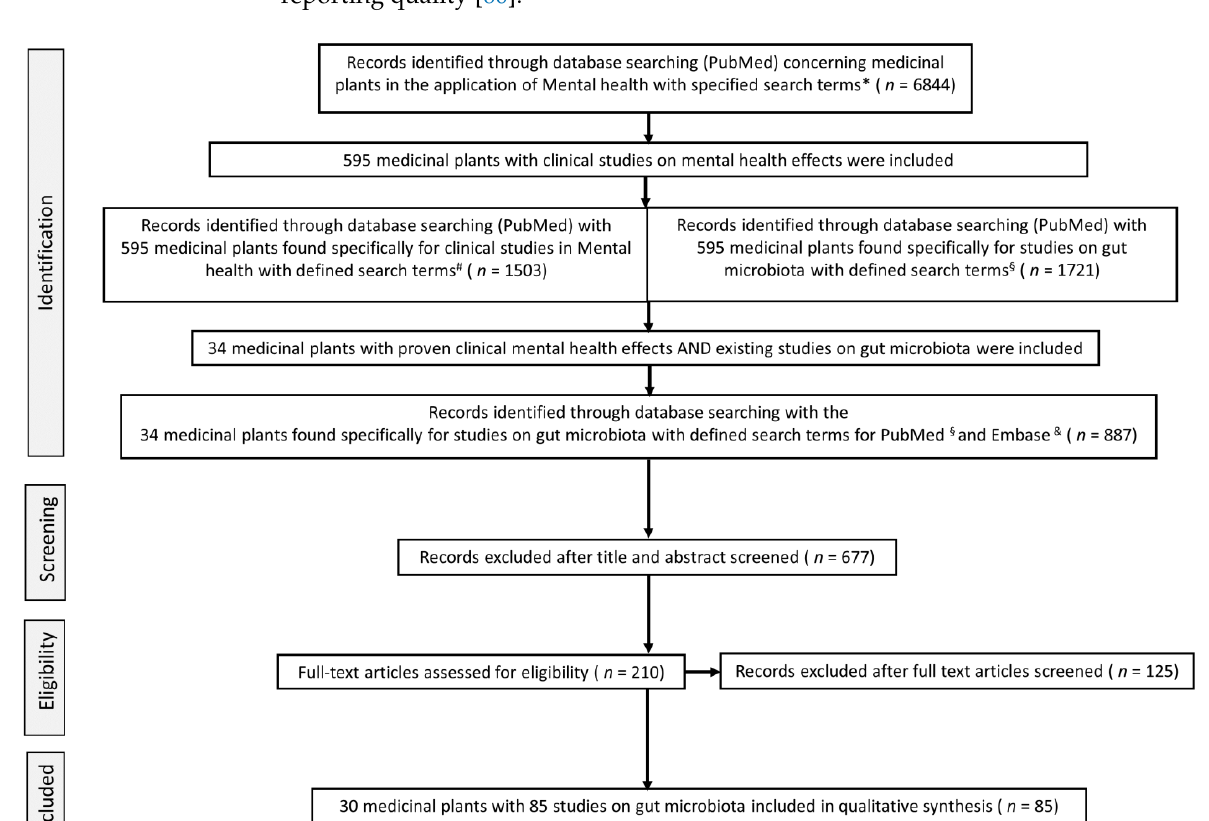
Figure 2. Flowchart of the selection strategy and method (PRISMA statement). * Search terms were as follows: ((medicinal plant *) AND ((antidepressant) OR (mental stress) OR (mood disorder*) OR (insomnia) OR (sleep) OR (anxiety) OR (cognitive impairment *) OR (circadian clock) OR (circadian rhythm) OR (dementia) OR (memory) OR (adaptogen*) OR (focus and attention) OR (fatigue)) NOT ((Alzheimer’s disease *) NOT (Parkinson’s disease *)). # Search terms were as follows: (plant name OR plant name OR ……) AND (clinical study) AND ((anxiety) OR (insomnia) OR (antidepressant) OR (cognitive impairment *) OR (fatigue) OR (memory)). § Search terms were as follows: (plant name OR plant name OR ……..) AND ((gut microbiome) OR (gut microbiota) OR (gut bacteria)) . & Search terms were as follows: “plant name” AND (“gut microbiome” OR “gut microbiota” OR “gut bacteria” OR “intestinal flora”).